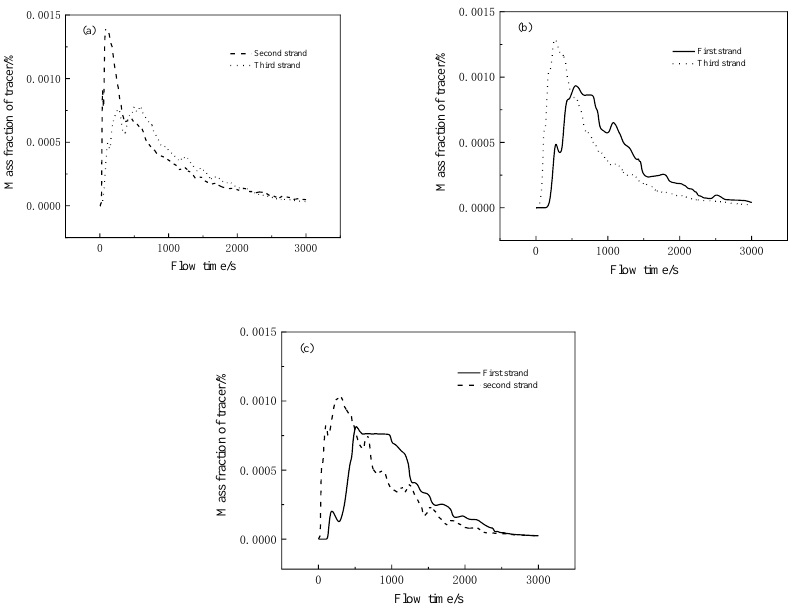
Figure 5. RTD curves of tundish for fewer strands casting: scheme 1 ( a ); scheme 2 ( b ); scheme 3 ( c ). Table 4. Numerical result of RTD curves in tundish with each scheme.